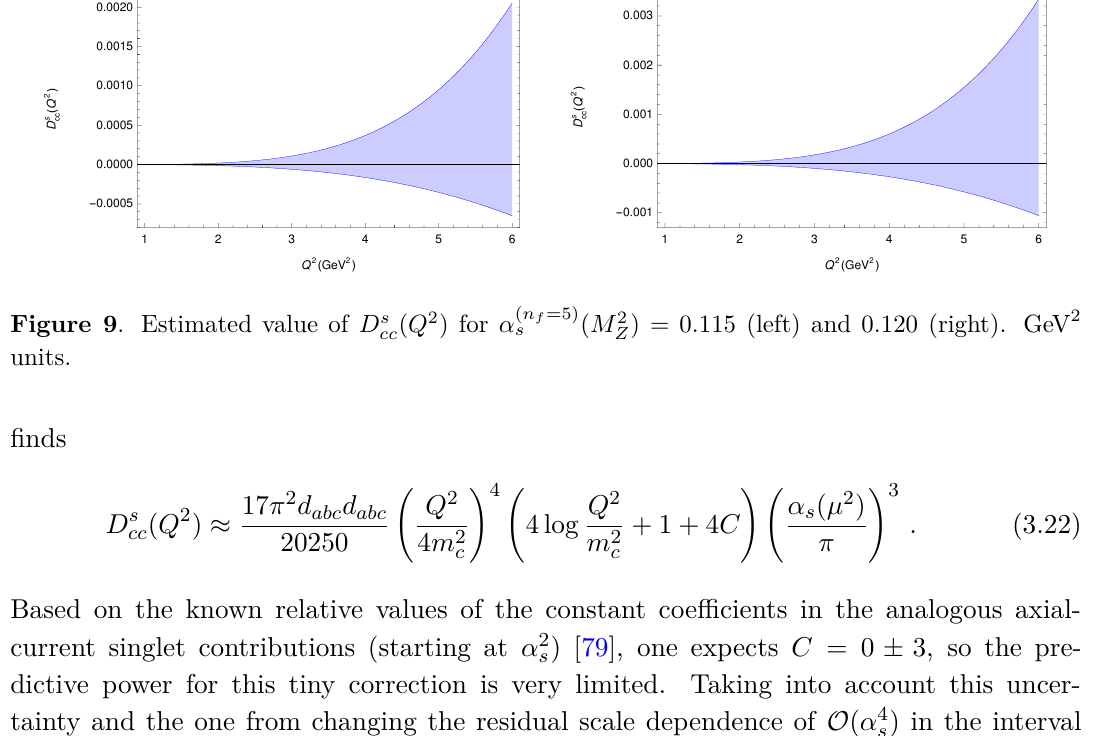
Figure 8 . D cc ( Q 2 ) at order α 2 and at different orders in the expansion of Q 2 / 4 m 2 s the convergence is better the higher the order of the expansion is. At the same time, when going beyond the radius of convergence, the higher the order the faster it goes to infinity.